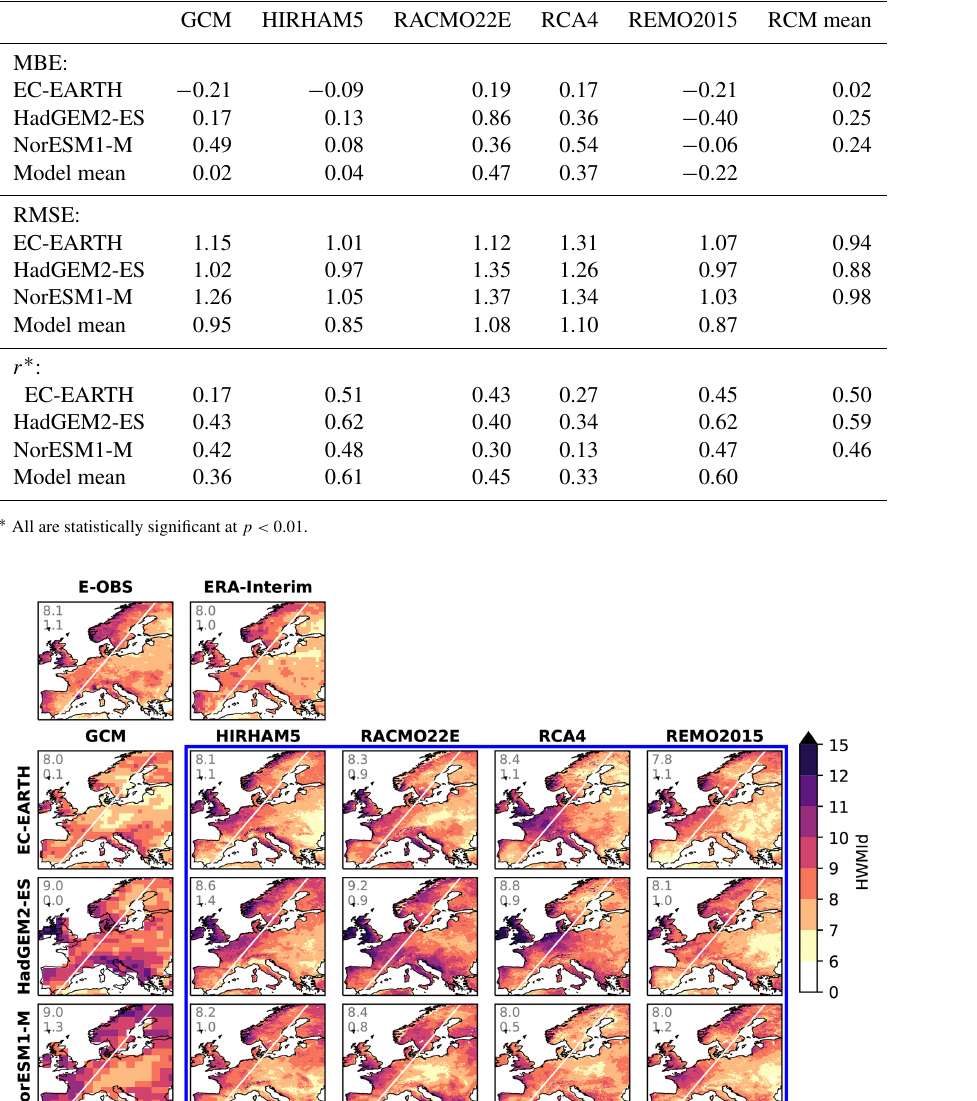
Table 4. Spatial MBE, RMSE, and r for the climatological mean HWMId over 1989–2008 (with reference period also as 1989–2008) in the selected GCM simulations and the GCM-driven simulations that compose the RCM simulation matrix (columns for RCMs and rows for their driving GCMs), with E-OBS as reference. For each statistic, an additional row is given for the column mean (i.e., along the GCM dimension) of the driving GCM simulations and the RCM simulation matrix.